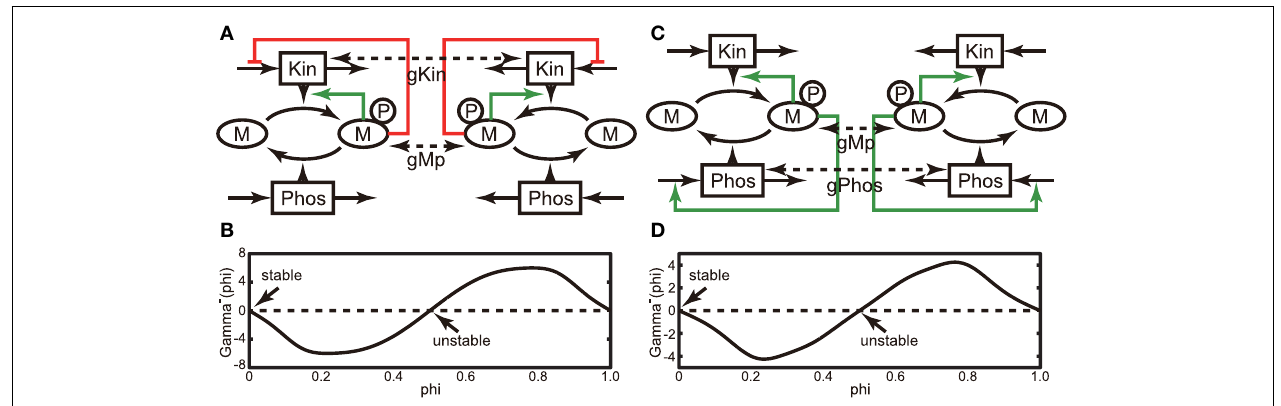
g Kin = 1. (C) Same as (A) , but Model B was used by assuming weak interactions between each Mp and Kin. (D) Gamma function of the coupled system shown in (C) , in which we adopted g Mp = 1 and g Phos = 1.